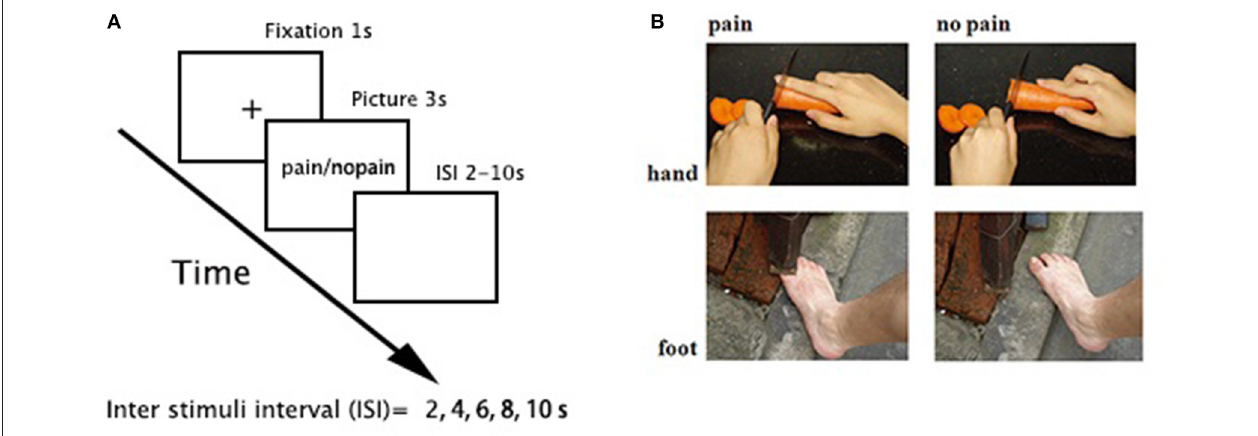
FIGURE 1 | Task paradigm. (A) a 3-s picture was presented in each trial, preceded by 1-s fixation and followed by a pseudorandom jittered inter stimuli interval (ISI, 2, 4, 6, 8, and 10s, with a mean = 6 ± 2s). The order of stimuli was pseudorandomly mixed in each run. (B) sample stimuli.